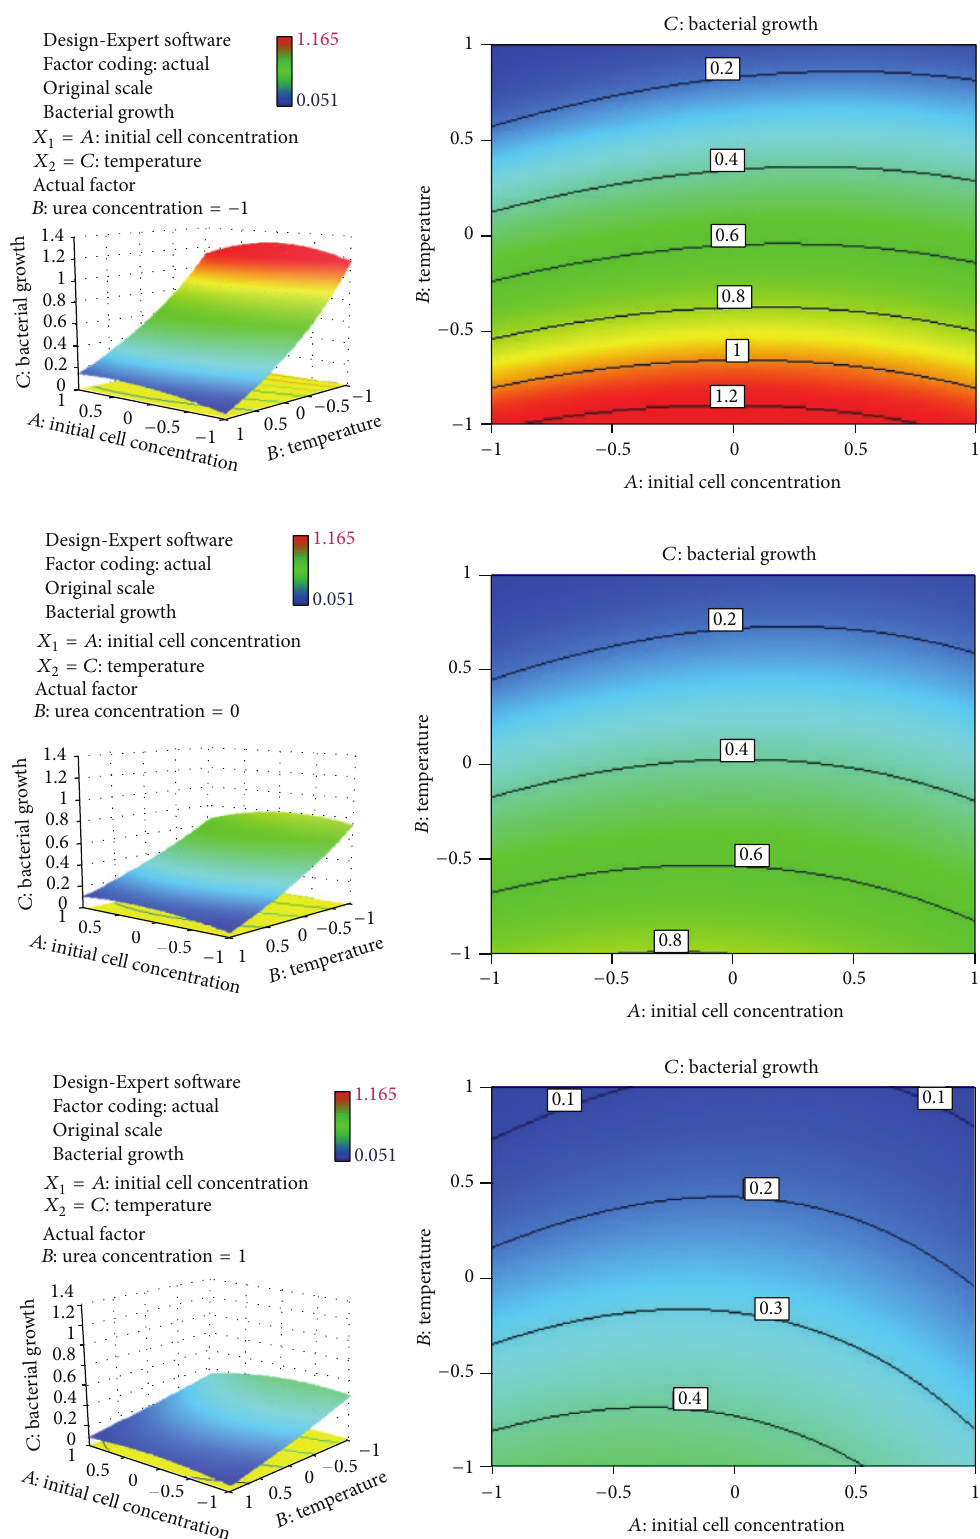
Figure 5: Response surface plots of the mutual effect of the factors on bacterial